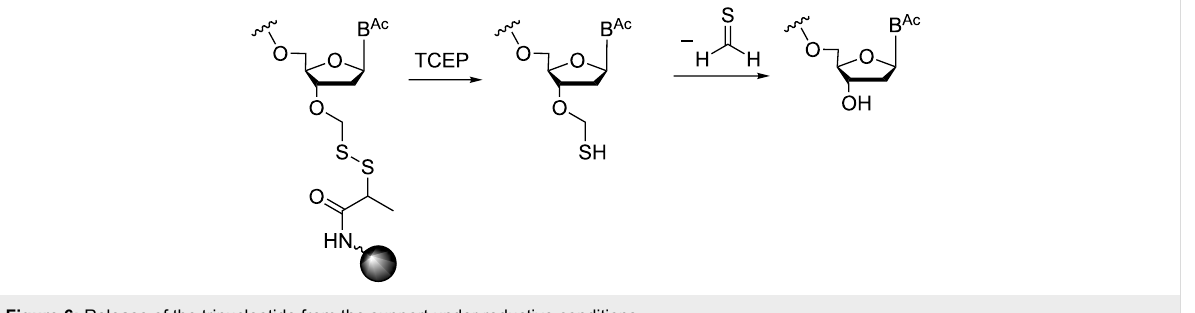
Figure 6: Release of the trinucleotide from the support under reductive conditions.